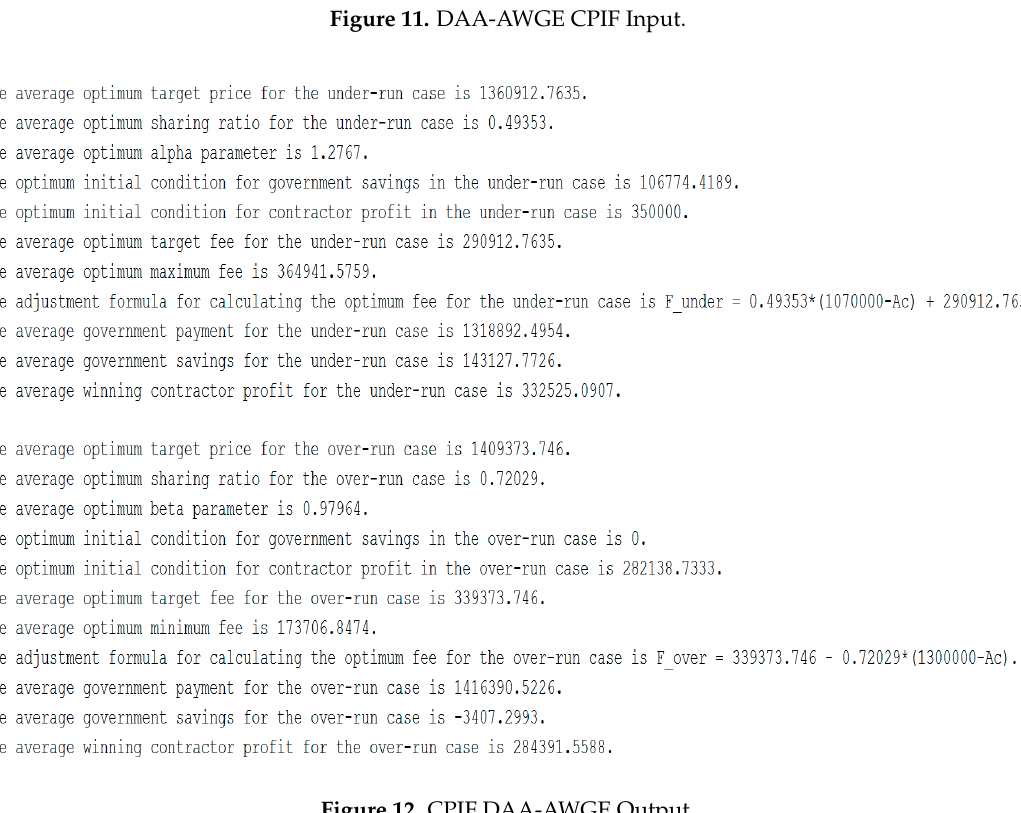
Figure 13. CPIF DAA-AWGE Average Government Payments.